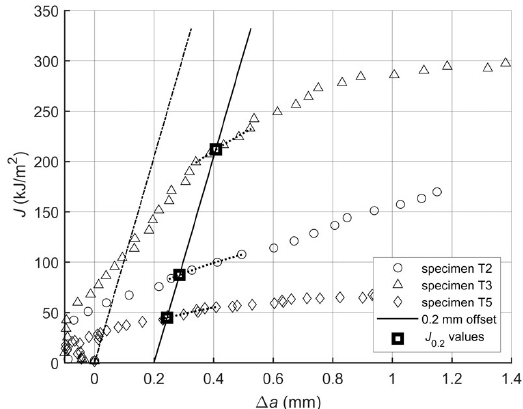
Figure 3. J ‐ R curves of selected specimens after fractographic correction of crack growth data. Parameters of J ‐ R curves reflect the force ‐ displacement records in Figure 2.